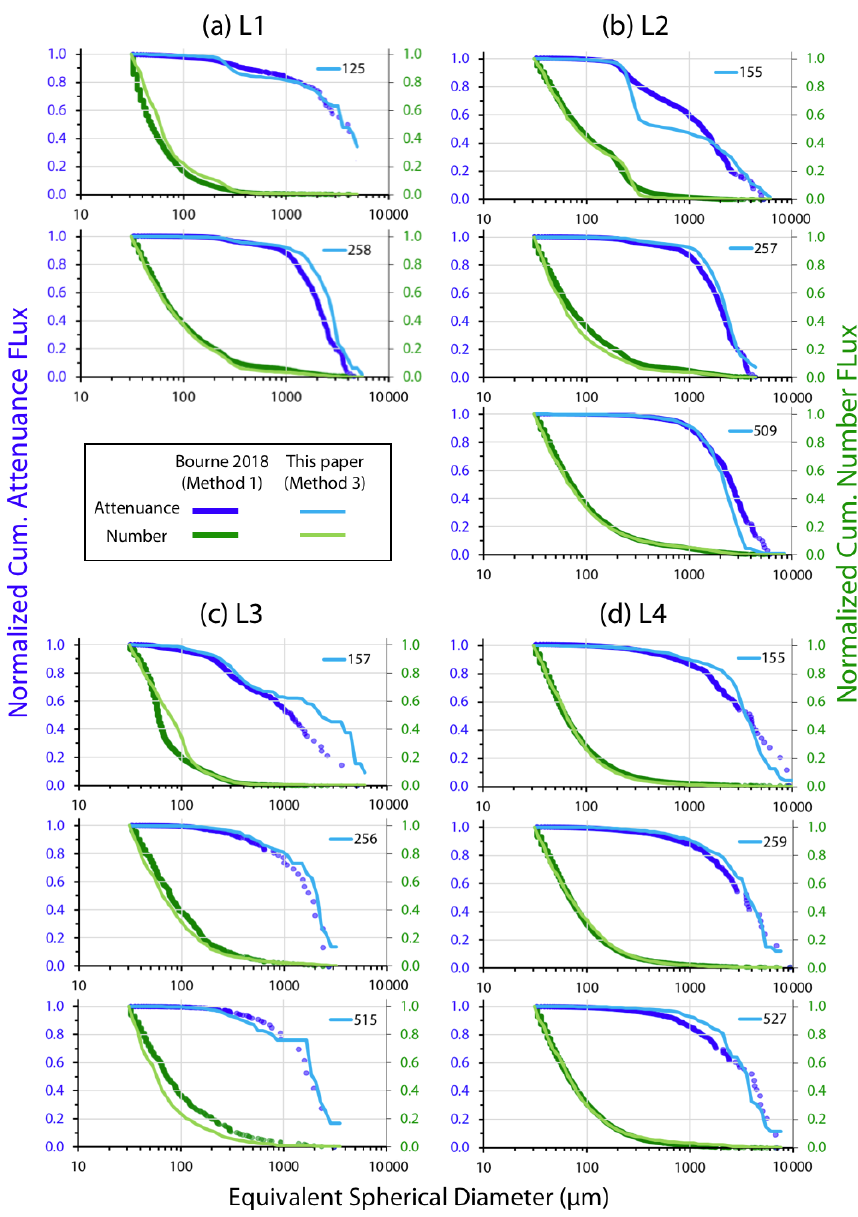
Figure A4. Comparison of normalized-cumulative-attenuance flux and normalized-cumulative-number flux size distributions determined using methods 1 (Bourne 2018) and 3 (this paper). The darker thicker lines are results from Method 1. In most cases, the two methods compare well at depths of 250 and 500m. The 150m data at L2 reflect touching faecal pellets not resolved by Method 1. The 150m data at L3 show the effects of Method 1’s failure to detect large low-attenuance